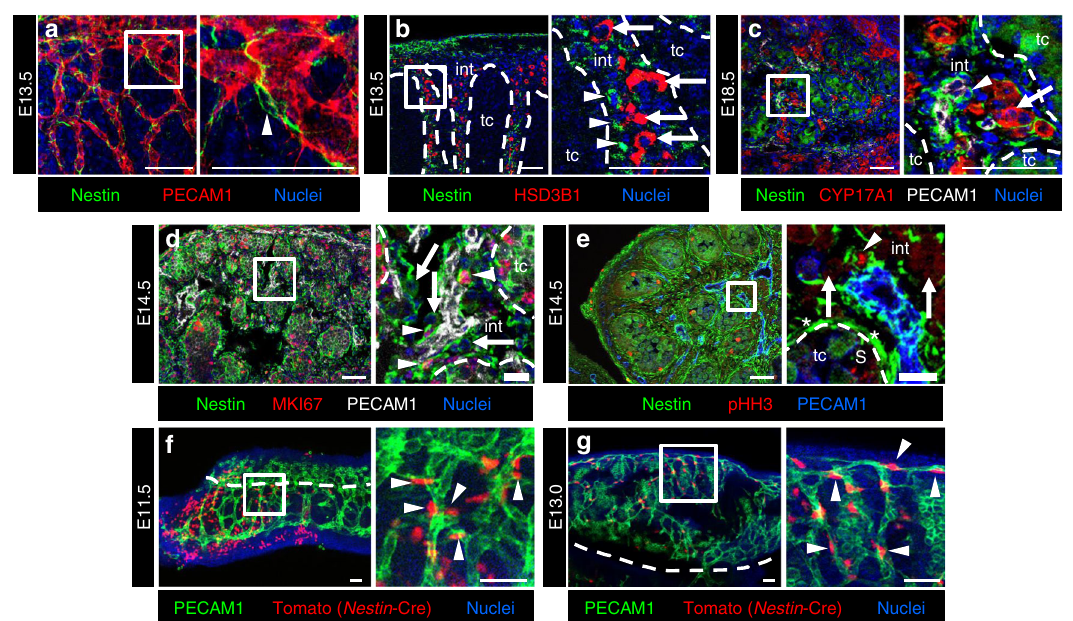
Fig. 2 Undifferentiated perivascular cells express Nestin. Immuno fl uorescence images of E11.5 ( f ), E13.0 ( g ), E13.5 ( a , b ), E14.5 ( d , e ), and E18.5 ( c ) wild- type CD-1 ( a – e ) and Nestin -Cre; Rosa- Tomato ( f , g ) fetal testes. In E13.5 ( a , b ) and E18.5 ( c ) fetal testes, Nestin-positive cells ( a – c , arrowheads) were localized close to the vasculature, as marked by PECAM1, and were mutually exclusive from differentiated Leydig cells, as marked by HSD3B1 ( b , arrows) or CYP17A1 ( c , arrow). Immuno fl uorescence images of E14.5 fetal testes ( d , e ) showed that Nestin-positive cells were MKI67-positive ( d , arrowheads; marker for cells in active cell cycle) or pHH3-positive ( e , arrowhead; marker for mitotic cells), while Leydig cells ( d , e , arrows) were MKI67-negative and pHH3- negative. In ( e ), “ S ” marks mitotic Sertoli cell and asterisks denote the expression of Nestin in peritubular myoid cells. Immuno fl uorescence images of E11.5 ( f ) and E13.5 ( g ) lineage-traced Nestin -Cre; Rosa -Tomato testes showed that Tomato-positive cells ( f , g , arrowheads) were located in close proximity to the vasculature. Dashed lines indicate the boundary of testis cords (tc) and interstitium (int) in ( b – e ) and the boundary between gonad and mesonephros in ( f , g ). Thin scale bars, 50 μ m; thick scale bars, 10 μ